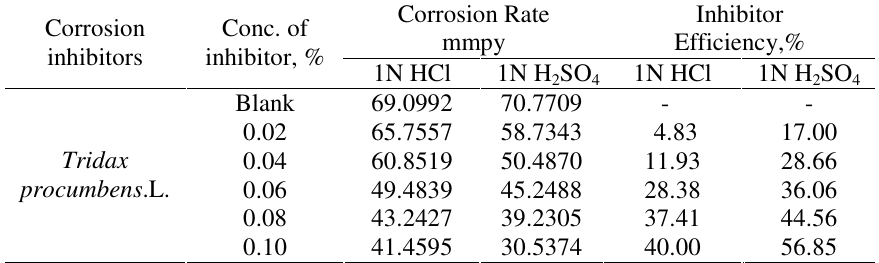
Table 2. Corrosion inhibition behaviour of mild steel in 1 N hydrochloric acid and 1N sulphuric acid solution in absence and presence of Tridax procumbens L. is studied